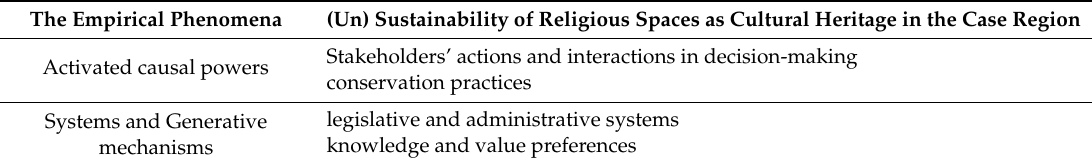
Table 2. The strata of realities in the case